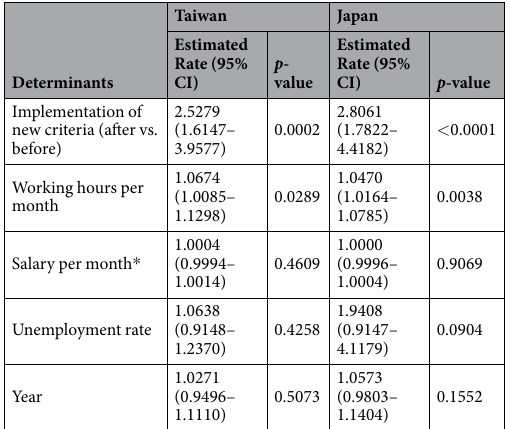
Table 5. Estimated marginal effects of determinants on rates of overwork-related cardiovascular and cerebrovascular diseases in Taiwan and Japan. The estimate intercepts are 1.3931 × 10 − 5 (95% CI = 3.0317 × 10 − 10 to 6.4013 × 10 − 1 , p -value = 0.0967) for Taiwan and 4.0529 × 10 − 4 (95% CI = 1.4069 × 10 − 6 to 1.1676 × 10 − 1 , p -value = 0.0426) for Japan, respectively. * Based on average annual exchange rate and adjusted for Consumer Price Index 18–21 .